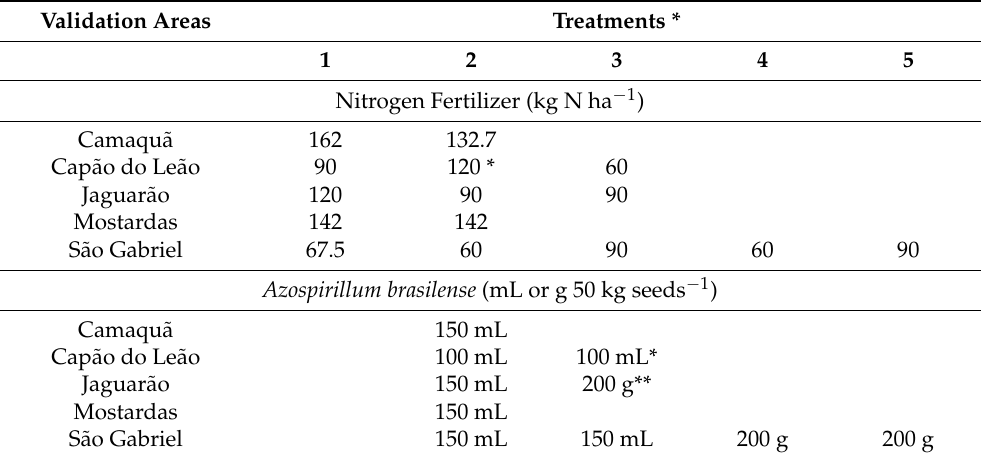
Table 5. Nitrogen doses used in rice crops in each validation area as a function of the combined treatments with Azospirillum brasilense in the liquid and peaty